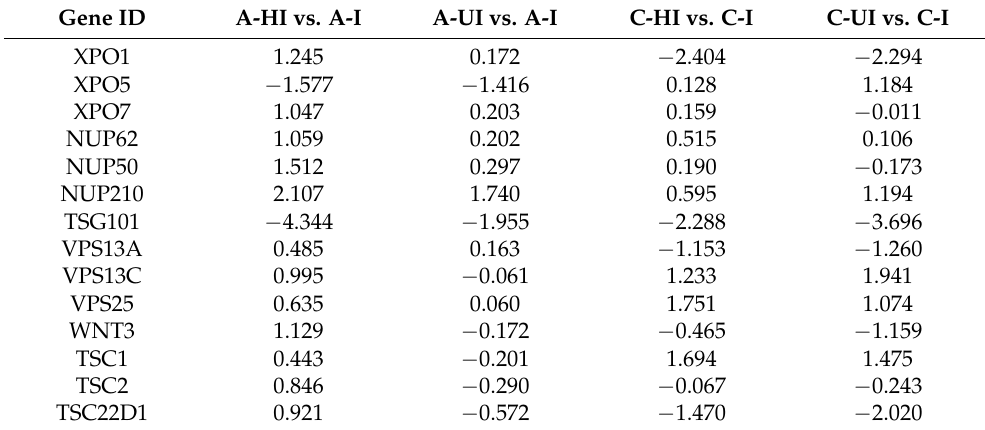
Table 3. Fold difference in the expression of genes by